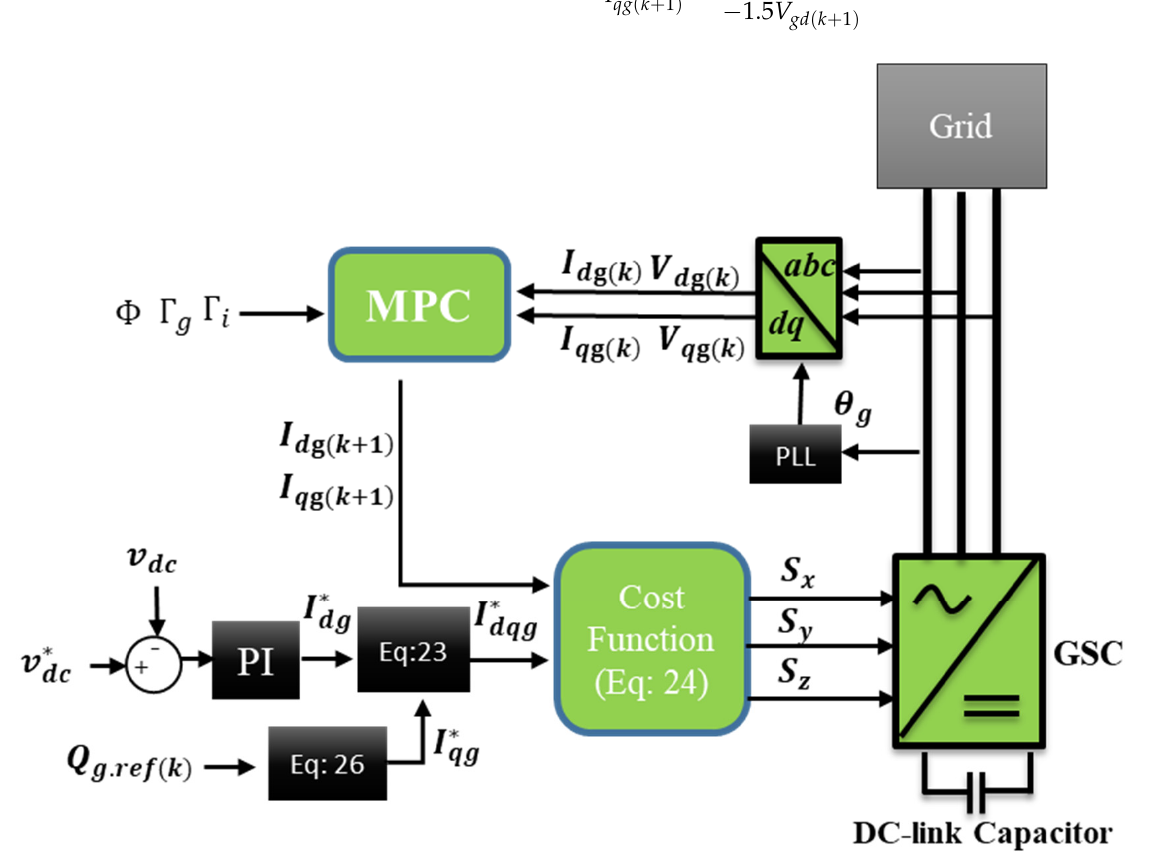
Figure 5. GSC with proposed FCS-MPC scheme.